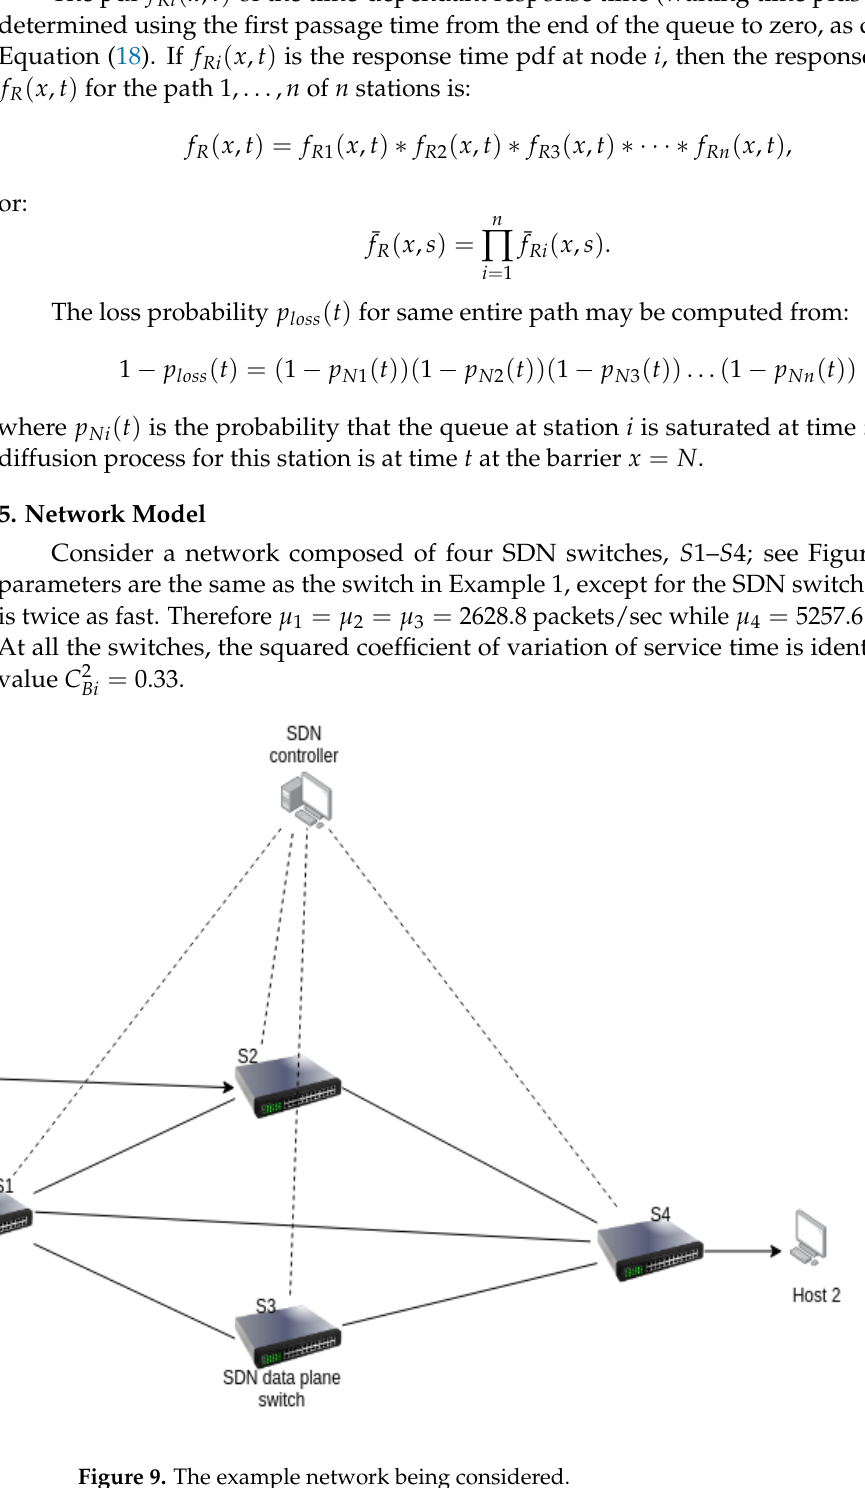
Figure 9. The example network being